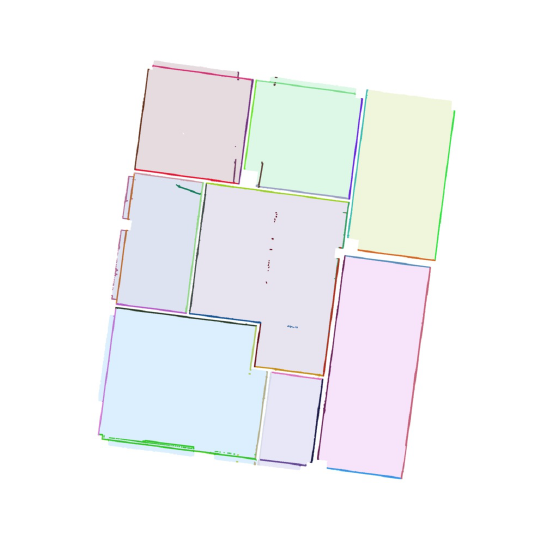
Door planes are segmented as they cover su ffi cient area, also notice the noise around outer windows and in the center